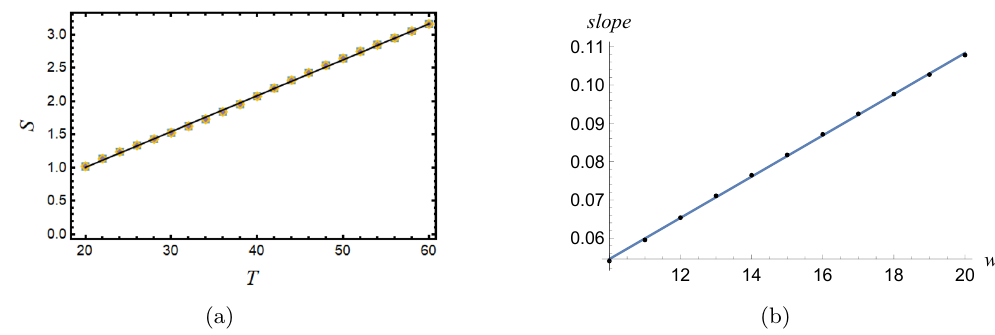
Figure 8 . (a) The time evolution of Rényi entropy of region A without coupling to the chaotic Majorana for N = 18 , 20 , . . . , 32 for w = 10 . It shows a single line because all the lines collapse into each other. (b) The fitted slope of time evolution of the Rényi entropy as a function of the hopping amplitude. We take w = 10 , . . . , 20 and T ∈ (20 , 60) . The parameters are β = 0 , J = 1 and V = 0 . We discretize T by 40 points.